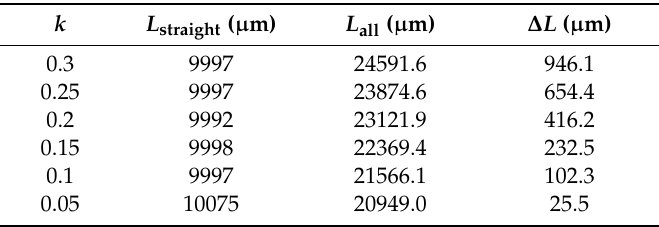
Figure 7. The parameters schematic of the Asymmetrical Mach–Zehnder Interferometer (AMZI) waveguide sensor with high sensing accuracy. Table 1. Asymmetrical Mach–Zehnder Interferometer (AMZI) sensor parameters associated with various length differences.